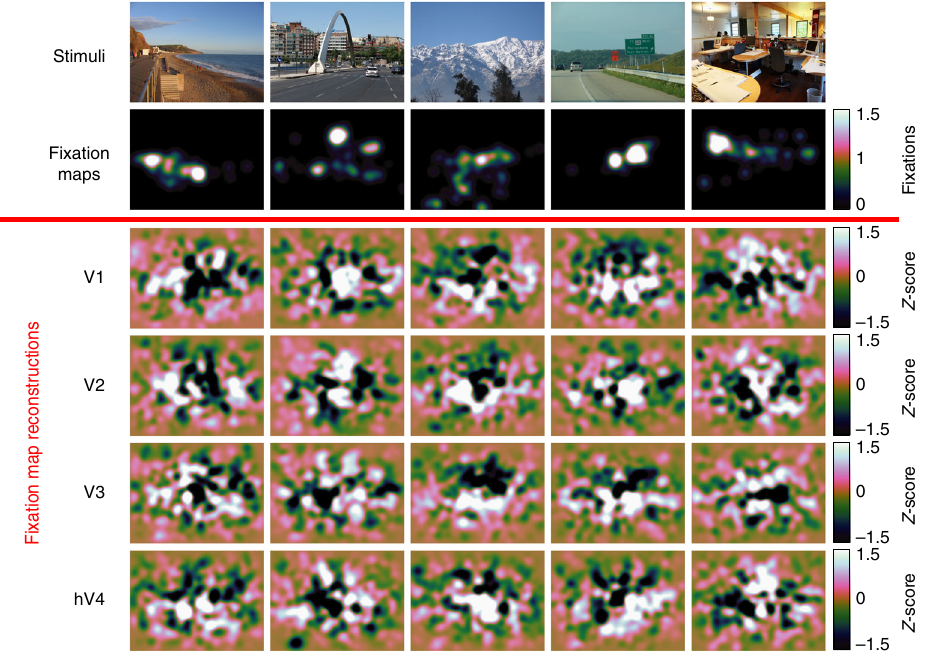
Fig. 2 Fixation maps reconstructed directly from fMRI activity in early-visual ROIs. Example stimuli, fi xation maps, and reconstructed fi xation maps from early-visual ROIs. Each column corresponds to an image that was shown to participants during the fMRI experiment. Fixation maps were averaged across all participants in the external validation data set ( n = 22) and fi xation map reconstructions were averaged across all participants in the main